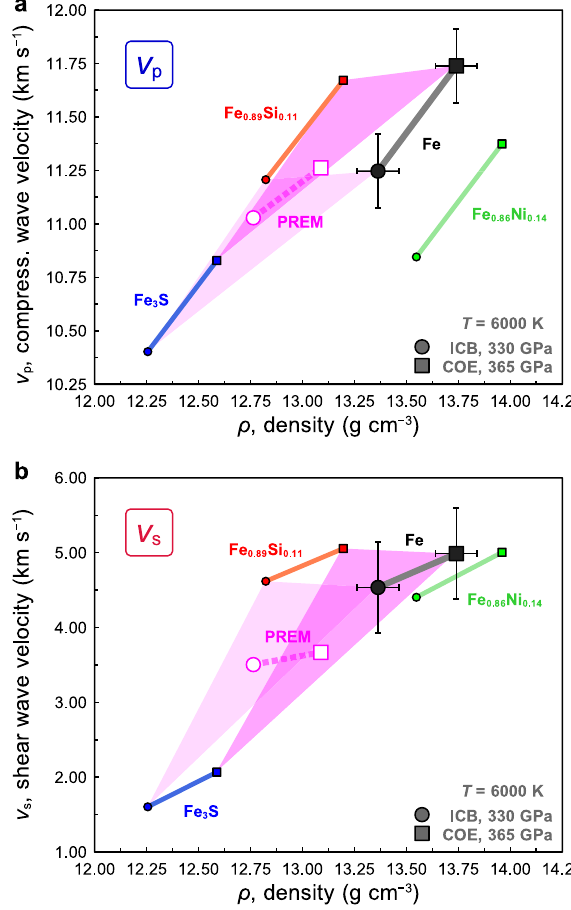
Fig. 4 | Comparison of density ‒ velocity relations of hexagonal close-packed (hcp) iron at inner core conditions with Preliminary reference Earth model (PREM). The v p de fi cit( a )andthe v s de fi cit( b )intheinnercore.The v p and v s ofthe PREM inner core (DA&AD81) 1 compared to those of hcp-iron at ambient tempera- ture(greydashedcurves)and6000K(red curves: fi tted v p ‒ ρ and v s ‒ ρ relations)at 330GPa (inner core boundary, ICB, and circle symbols) and 365GPa (centre of the Earth/core,COE,andsquaresymbols).Theequationofstateofhcp-ironbyDewaele et al. 3 was used for the calculation. The v p de fi cit and the v s de fi cit are 2(±2)% and 29(±17)% at the ICB, and 4(±2)% and 36(±17)% at the COE, respectively. The error bars represent 1 σ